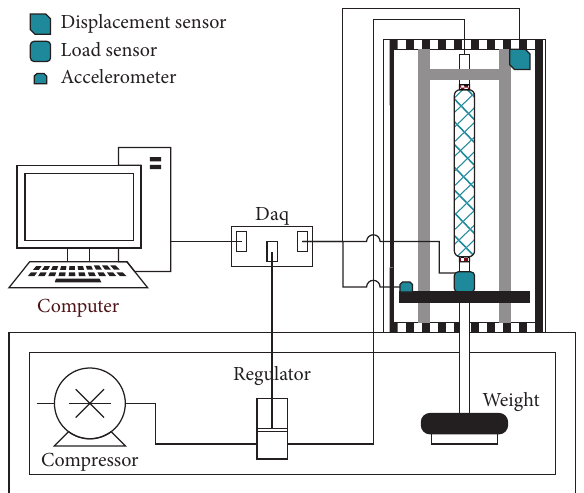
Figure 2: Experimental setup for the vertical load system with single